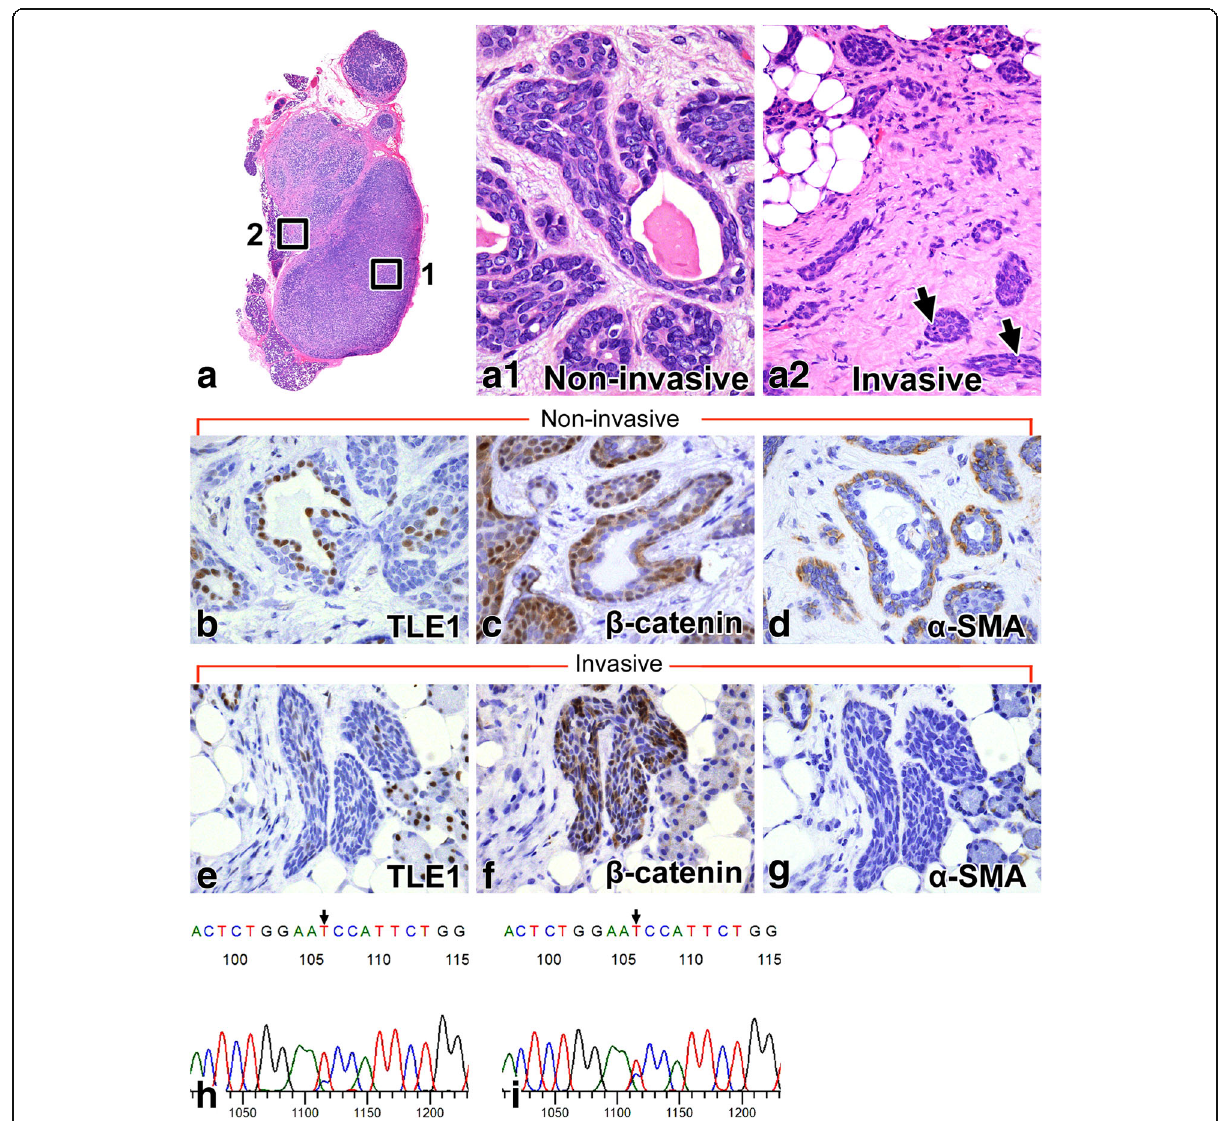
Fig. 3 Basal cell adenocarcinoma (BCAC). BCAC histology ( a : low magnification, a1: high magnification of square 1, a2: high magnification of square 2) with hematoxylin-eosin staining are shown. A multinodular tumor ( a ) forms a tubular, trabecular, solid growth pattern in non-invasive areas (a1), and small tumor nests infiltrate the surrounding parenchyma (a2). They show slightly increased mitotic activity (arrows in a2). BCAC of non-invasive areas ( b - d ) and invasive areas ( e - g ) with TLE1( b , e ), β -catenin ( c , f ), and α -SMA ( d , g ) immunostaining, respectively, are shown. In non-invasive areas, luminal cells are positive for TLE1( b ), abluminal cells are positive for β -catenin( c ), and the lining of myoepithelial cells are positive for α -SMA( d ). In invasive areas, luminal cells staining for TLE1( e ) becomes indistinct, abluminal cells positivity for β -catenin( f ) remains unchanged, and the α -SMA( g ) lining myoepithelial cells disappear. Mutational analysis for CTNNB1 detected the same mutation on both areas of the tumor ( h : non-invasive areas, i: invasive areas, BCAC case